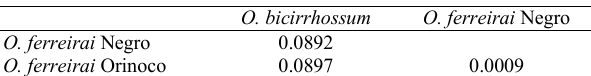
Table 1. Table of K2P distances (Kimura, 1980) between the two species of Osteoglossum and the Negro and Orinoco River populations of O. ferreirai